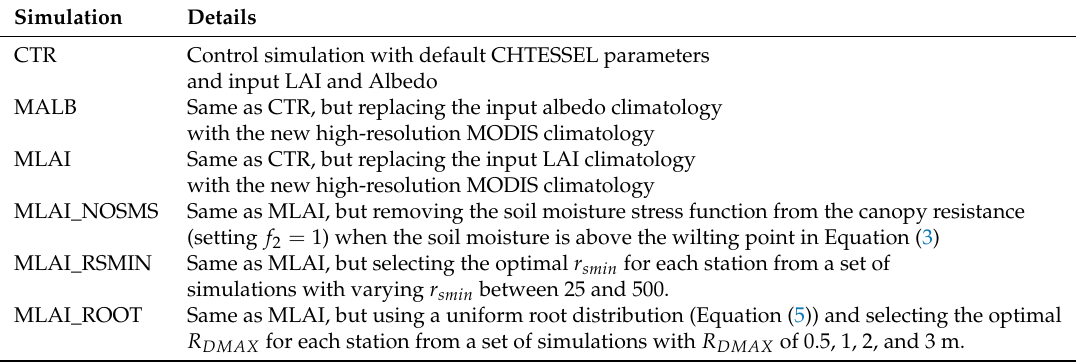
Table 3. Model simulations acronyms and detailed configuration.